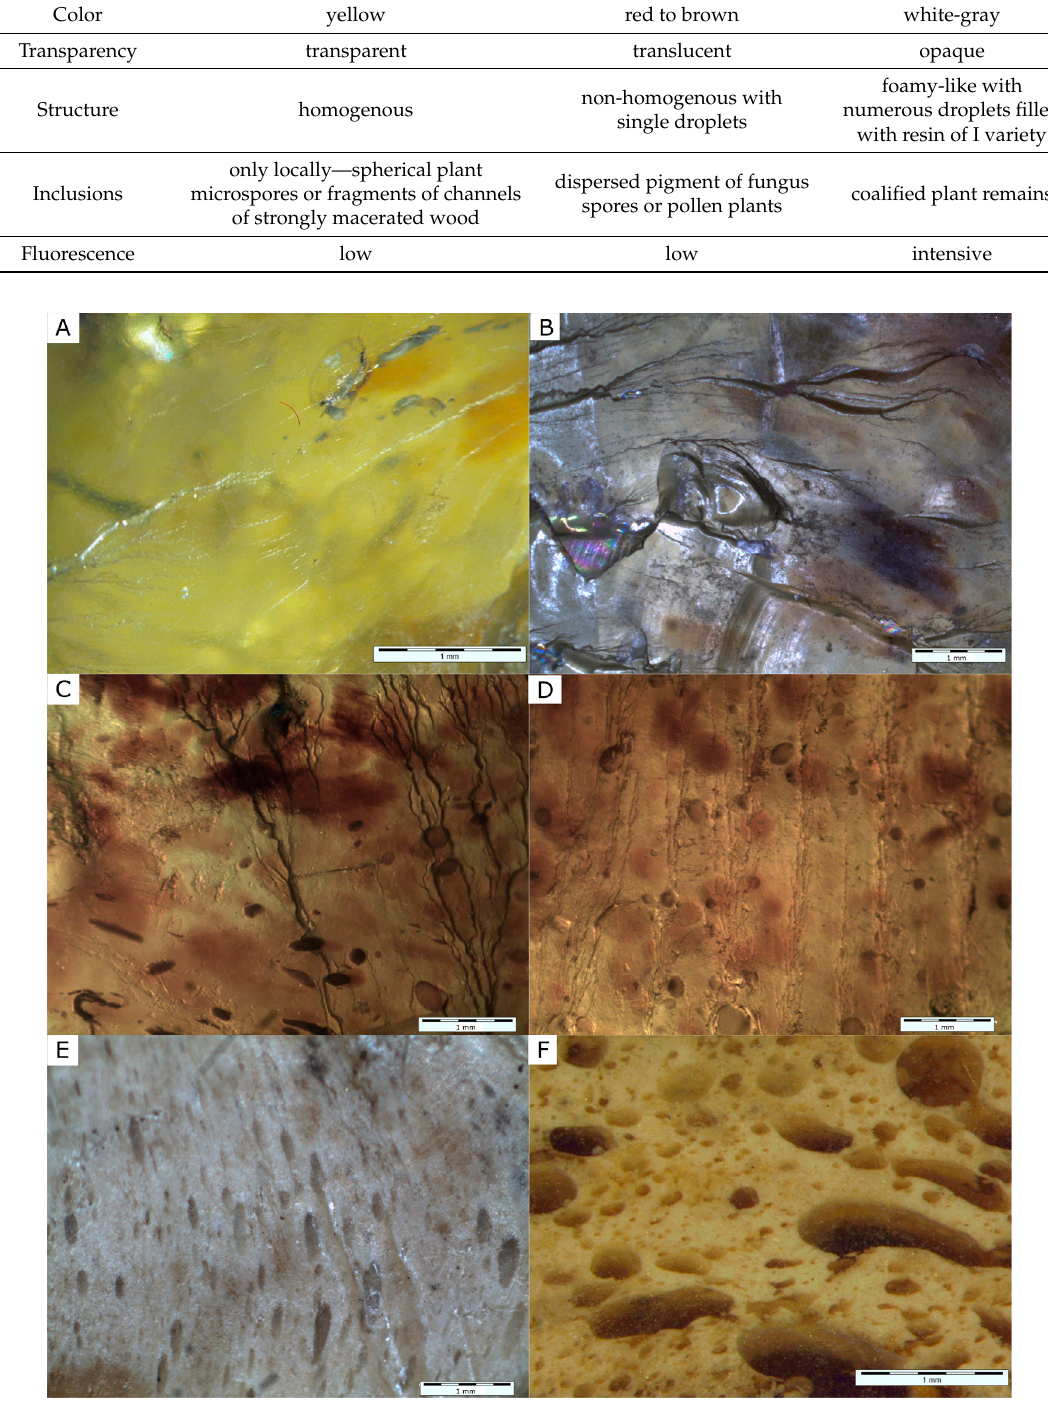
Figure 3. Stereoscopic photographs of samples; from the top: ( A , B ) bright yellow (variety I); ( C , D ) dark (variety II) and ( E , F ) opaque (variety III) of resins.